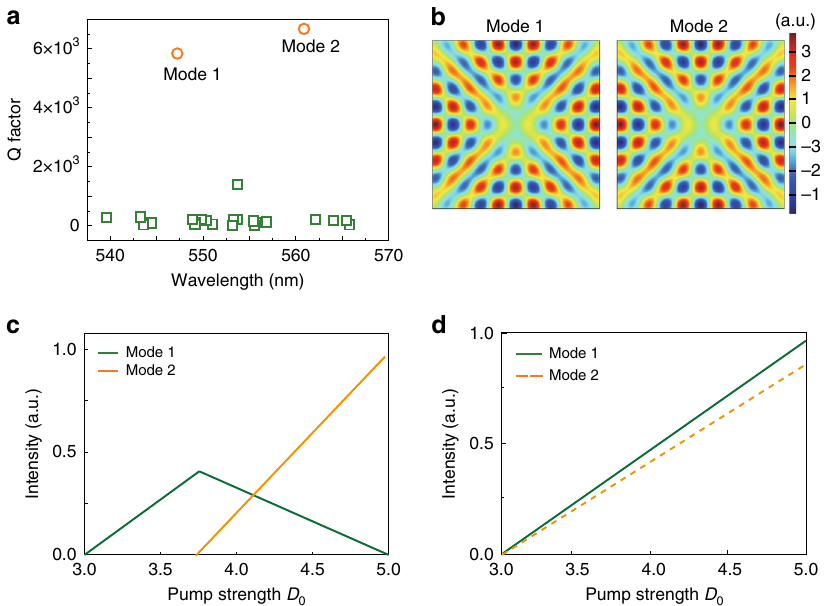
Fig. 4 The mechanism for mode switching. a The numerically calculated Q factors in the cross-section of MAPbBr 3 perovskite microrod. b The fi eld patterns of two high Q resonances. c The output intensity of two modes as a function of pumping power when the modal interaction is considered. d The control simulation without considering the modal